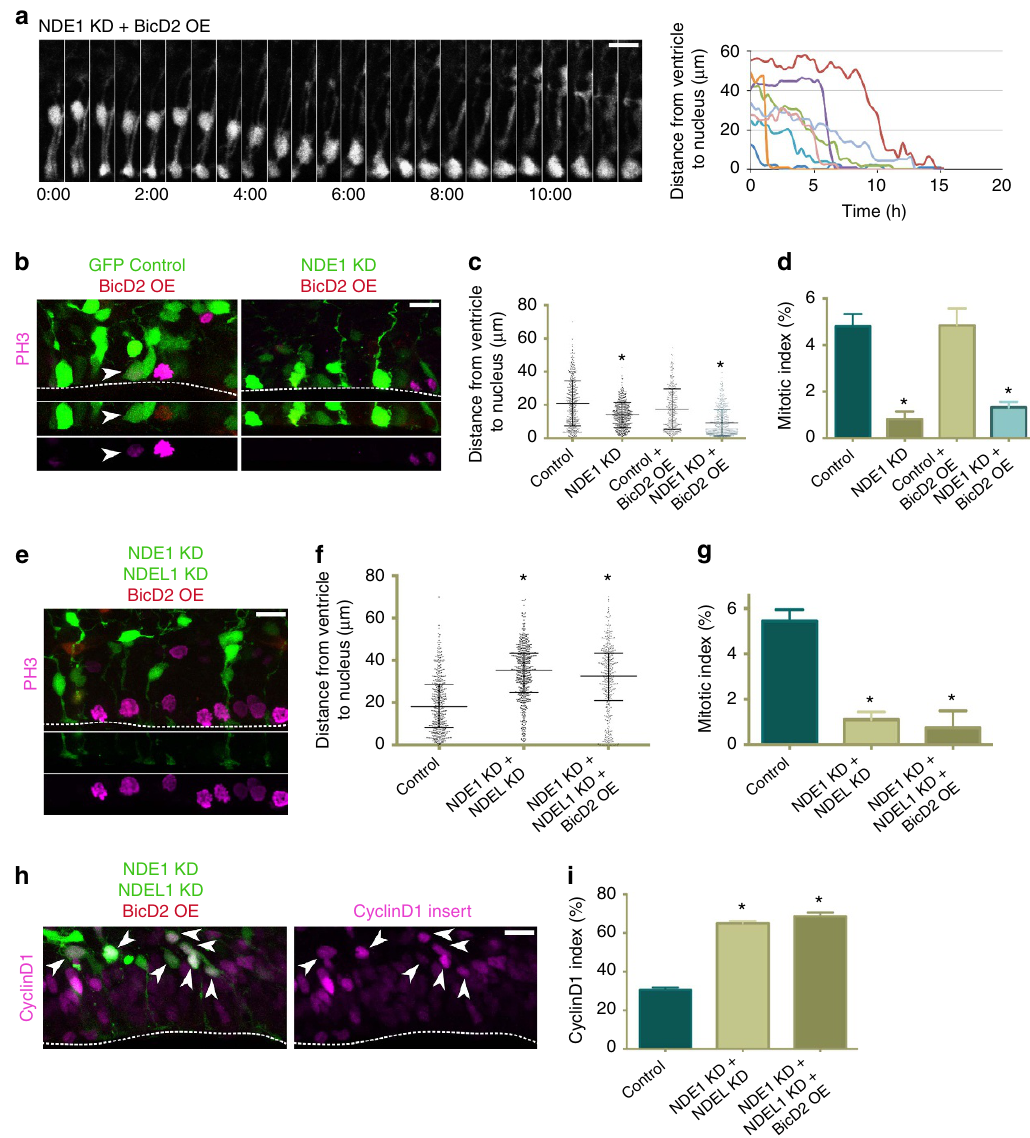
Figure 8 | BicD2 overexpression rescues apical nuclear migration but not entry into mitosis in radial glia progenitors depleted of NDE1. cDNA for full- length BicD2 was co-electroporated into embryonic rat brains with a GFP control empty vector or along with NDE1 shRNA or NDE1 and NDEL1 shRNAs at E16, and analysed at E20. ( a ) The overexpression of BicD2 in radial glia progenitors (RGPs) lacking NDE1 restores apical migration, though the soma accumulate at the ventricle for hours without any evidence of mitosis. Montage panels are shown at 30min intervals. Full movie can be found in Supplementary Movie 8. ( b ) Representative images of BicD2 overexpression on both a wild-type and NDE1 knockdown background with staining for PH3. Arrowheads mark mitoses in electroporated cells. Dashed line indicates ventricular surface. ( c ) BicD2 overexpression did not alter the somal distribution of control RGP cells but caused the vast majority of NDE1 knockdown RGP soma to accumulate at the ventricular surface. ( d ) Despite the accumulation of RGP soma at the ventricle in NDE1 knockdown with BicD2 overexpression, the mitotic index remained reduced. ( e ) Representative image of RGP cells with BicD2 overexpression along with double NDE1/NDEL1 knockdown, stained for PH3. Dashed line indicates ventricle. ( f , g ) Overexpression of BicD2 with NDE1/NDEL1 double knockdown fails to rescue the somal distribution pattern or mitotic index of double NDE1/NDEL1 knockdown RGP cells. ( h , i ) The same ratio of RGP nuclei were positive for CyclinD1 whether or not BicD2 was overexpressed along with the double NDE1/NDEL1 knockdown, indicating the prominence of the G1-to-S block in the double knockdown, and the G2 specificity of the BicD2 rescue strategy. Arrowheads mark electroporated RGP nuclei positive for CyclinD1. Dashed line indicates ventricle surface. Data are presented as scatterplot in c and f with bars representing the median ± the interquartile range, and as mean ± s.e.m. in d , g and i . Kolmogorov–Smirnov test for non-parametric distributions used in c and f (* P o 0.05, n ¼ 407–591 RGP cells in c and n ¼ 421–487 RGP cells in f ). Unpaired t -test used in d , g and i (* P o 0.05, n ¼ 3 embryonic brains from different mothers). Scale bars, 10 m m. Also see Supplementary Fig. non-mitotic stages of RGP cell cycle progression that are susceptible to reduction in NDE1 or both NDE1/NDEL1, each